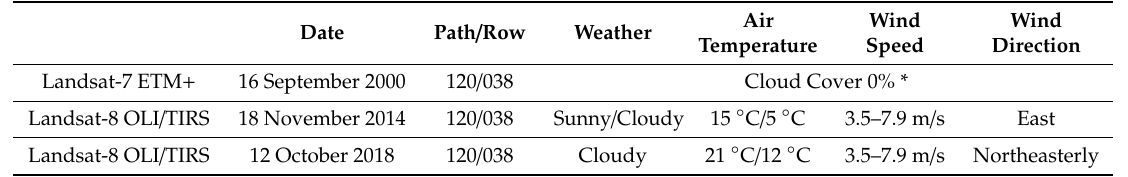
Table 1. List of Landsat images selected for the study.